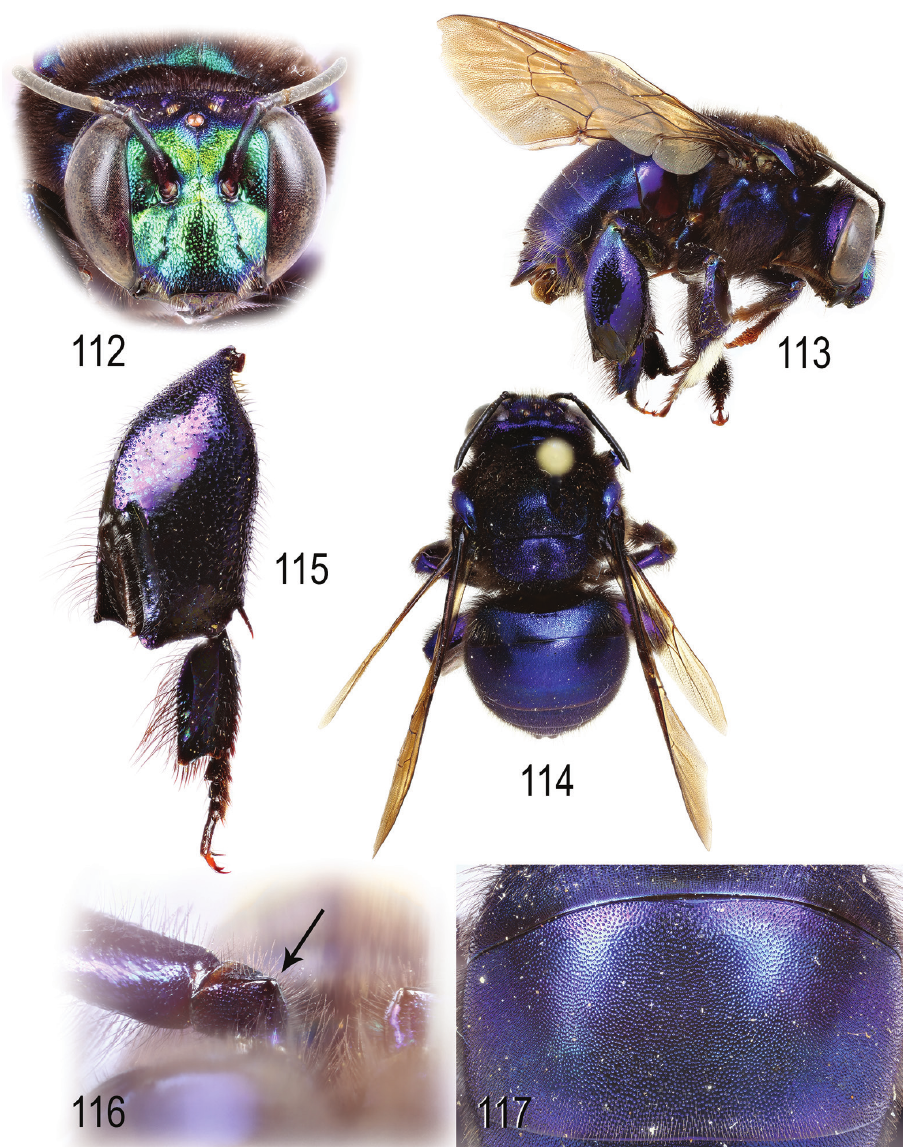
Figures 112–117. Male paratype of E. micheneri (Mexico: Jalisco, Mascota, KUNHM-ENT 1121713). 112 Facial view 113 Lateral habitus 114 Dorsal habitus; 115 Outer view of hind leg 116 Ventral view of metatrochanter with arrow pointing to distinct projection 117 Second metasomal